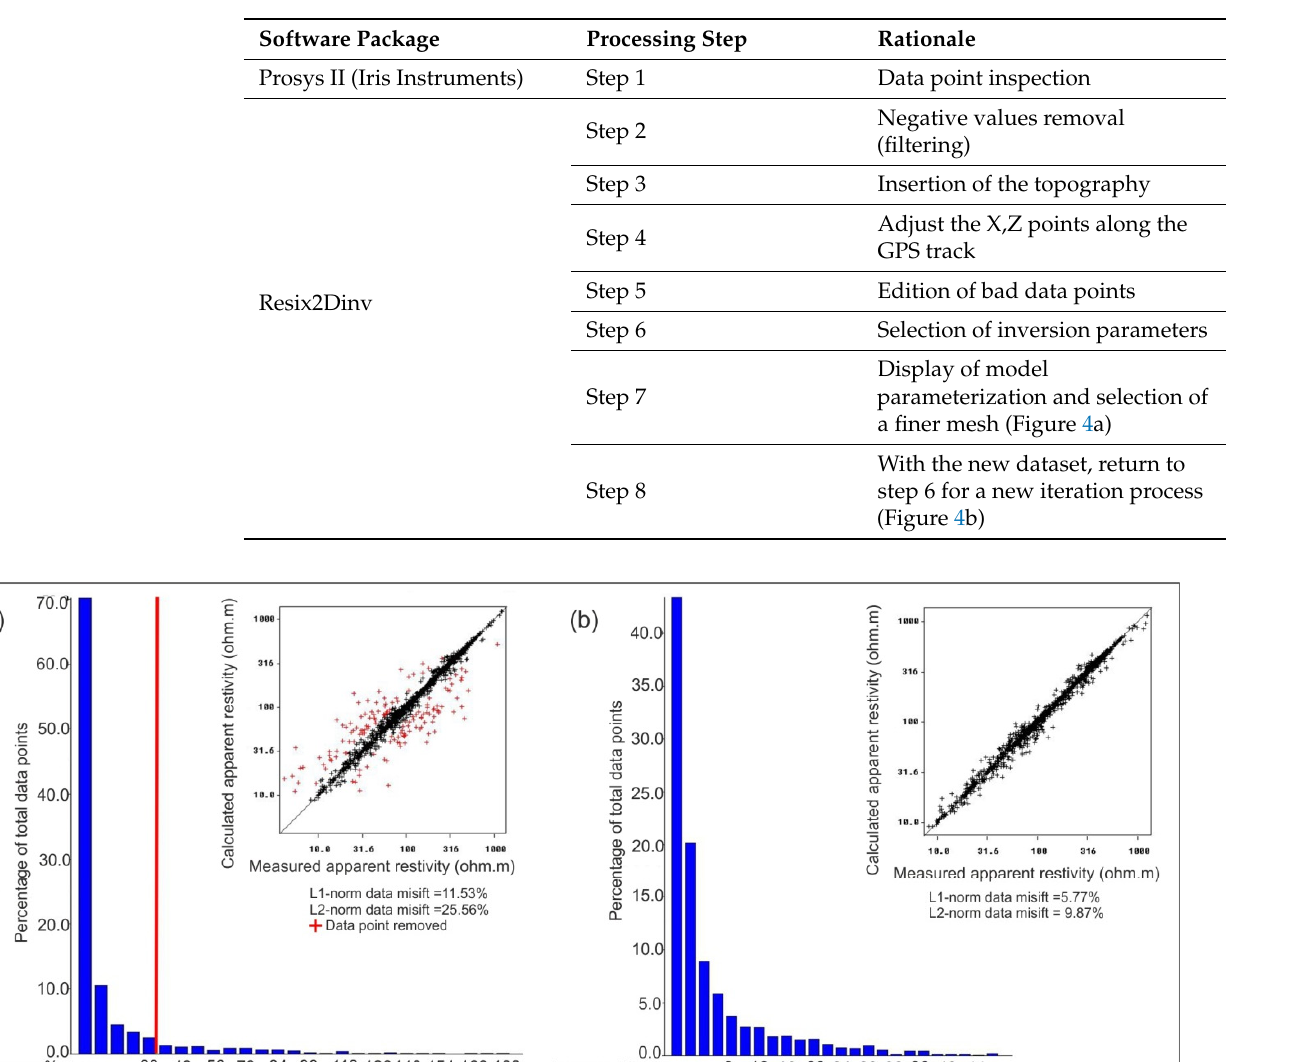
Table 1. Processing workflow used to obtain the ERT models in La Torrecilla and La Salud North profiles.